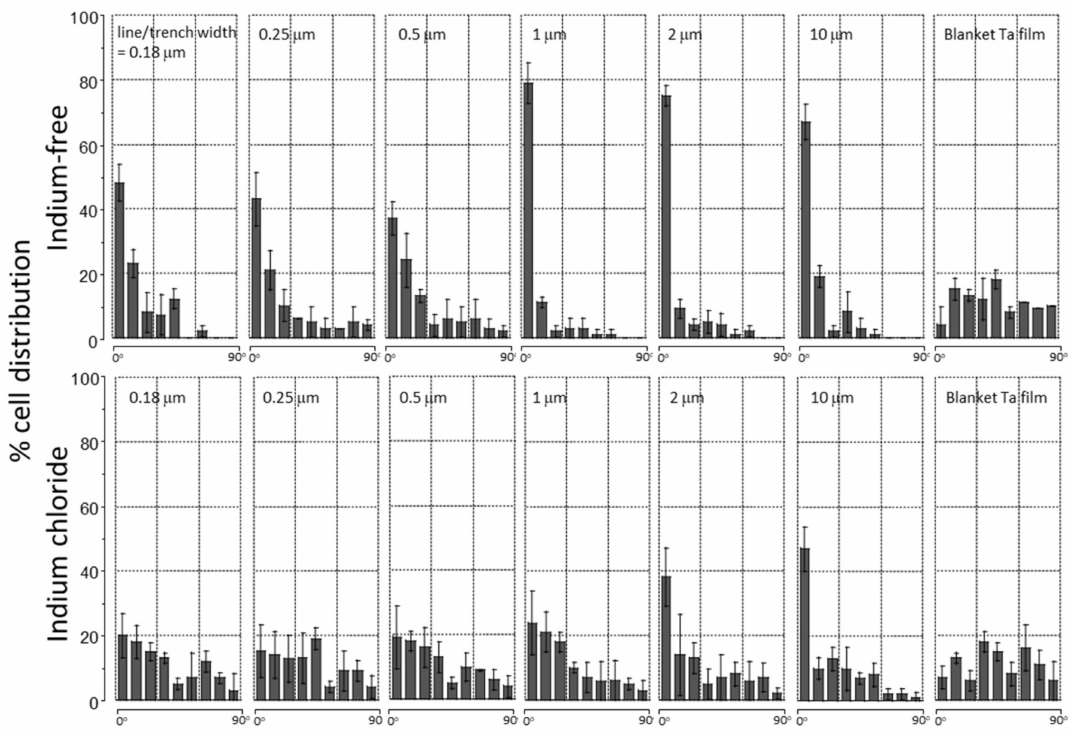
Figure 7. Percent distribution of cell aligned on parallel line structures with equal line/trench widths of 0.18 µ m, 0.25 µ m, 0.5 µ m, 1 µ m, 2 µ m and 10 µ m. The orientation of 100 randomly selected cells was measured in each geometric patterned area. The data spread corresponds to one standard deviation. The top and bottom panels display results from cells cultured in medium without and with indium chloride,